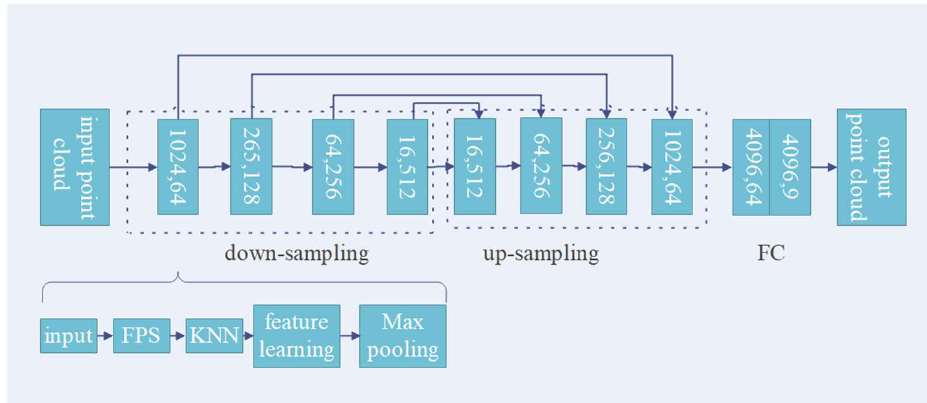
Figure 1. Structure of PointNet++.